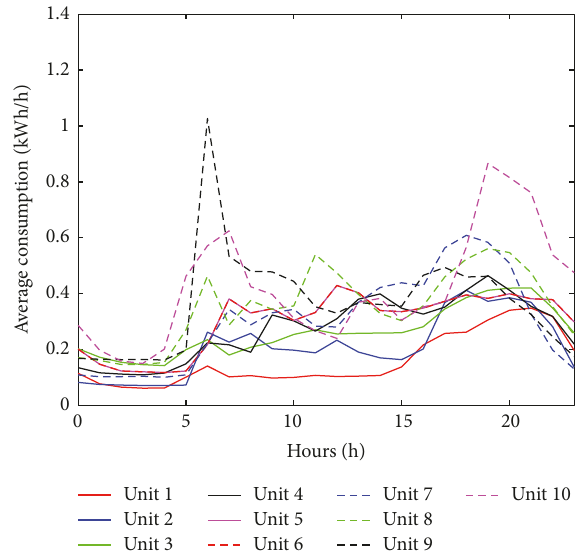
Figure 1: Hourly consumption